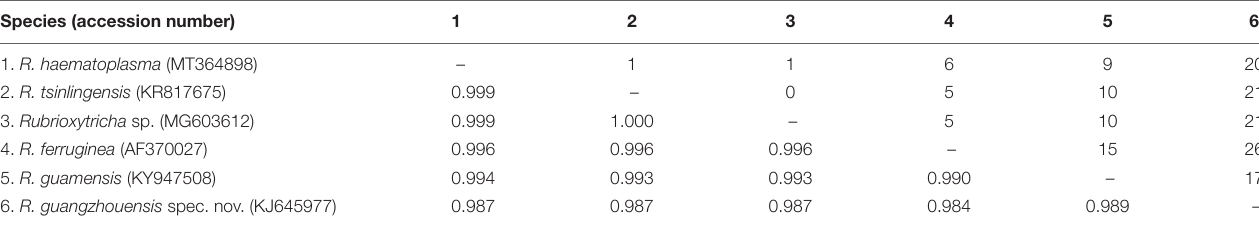
TABLE 2 | Numbers of unmatched nucleotides (upper right) and distribution of percentages of sequence identity (lower left) to all available 18S rRNA gene sequences of Rubrioxytricha species. Species (accession